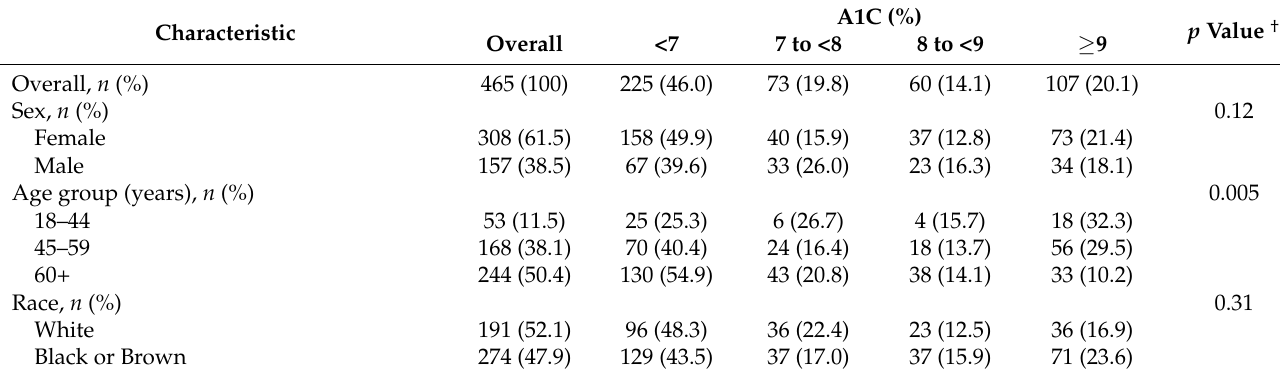
Table 1. Socio-demographics and clinical characteristics of individuals with self-reported diabetes overall and according